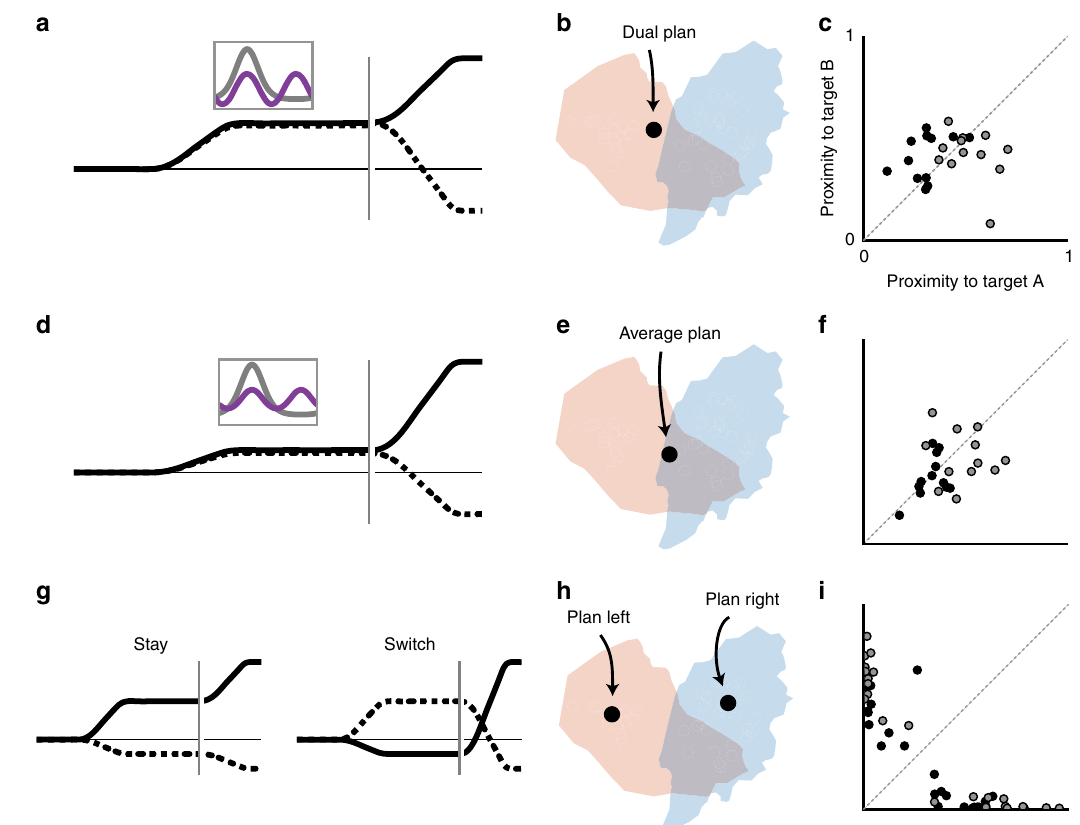
Fig. 4 Model predictions of low-dimensional states. a Illustration of pro-PD (solid) and anti-PD (dashed) activity on a 2-Target trial under a dual-target model based on Cisek and Kalaska 11 . Inset shows example 1-Target (gray) and 2-Target (purple) turning curves. b Simulated activity from the model in a for a left/right trial results in a low-dimensional neural state between the left and right 1-Target planning states. c Proximity plot of the simulated simultaneous representation states for all target axes. Symbol color corresponds to monkey (black, monkey C; gray, monkey M). d – f Same for averaged-plan model. g – i Same for stay-or-switch (bimodal) tuning curves. From the bimodal curves, we simulated (Fig. 5b, left — high density along x - and y -axes). Across all activity for the left/right target pair from Fig. 3a; the resulting neural state was close to both the left- and right-plan clusters (Fig. 4b). Across all target pairs and sessions, simulated dual- target neural states tended to lie near both reach direction clusters (Fig. 4c, points close to diagonal).